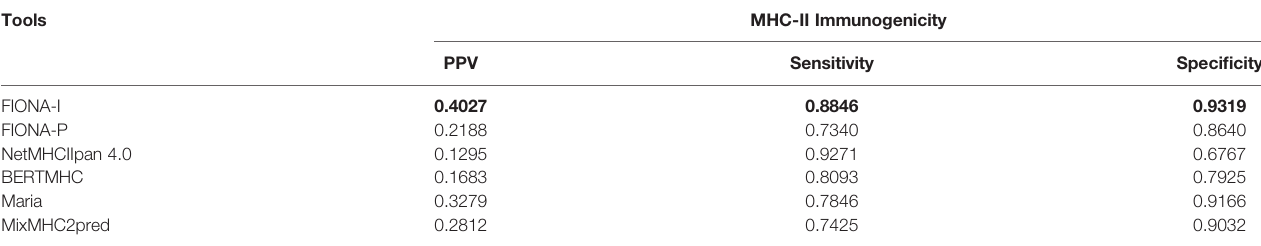
Bold means highlight superiority of our